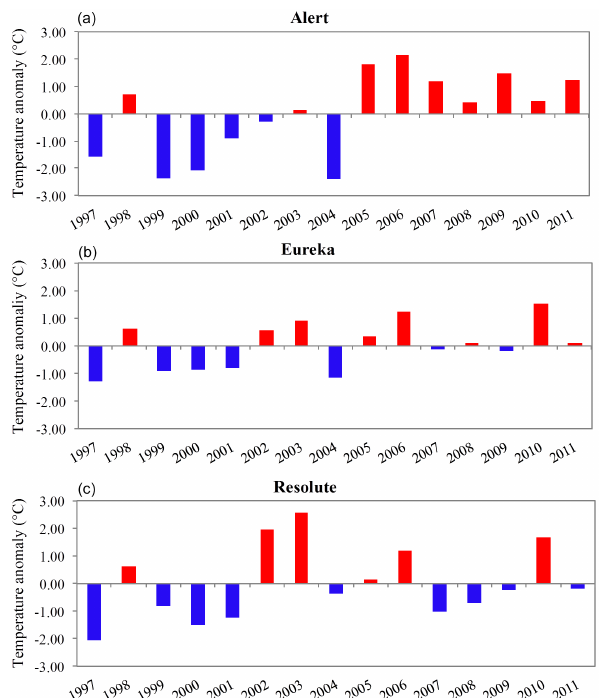
Figure 3. Air temperature anomalies for (a) Alert, (b) Eureka, and (c) Resolute relative to the 1997–2011 mean annual